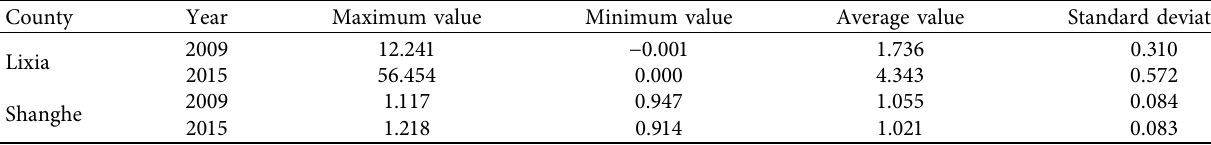
Table 2: Rurality index statistics.